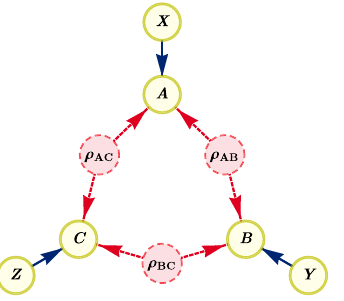
FIG. 10. The quantum triangle scenario with settings, some- times denoted Q △ for brevity. Each of the observable variables A , B , and C are now dependent not only on the sources of bipartite entanglement, but on additional observable classical variables X , Y , and Z representing measurement choices.